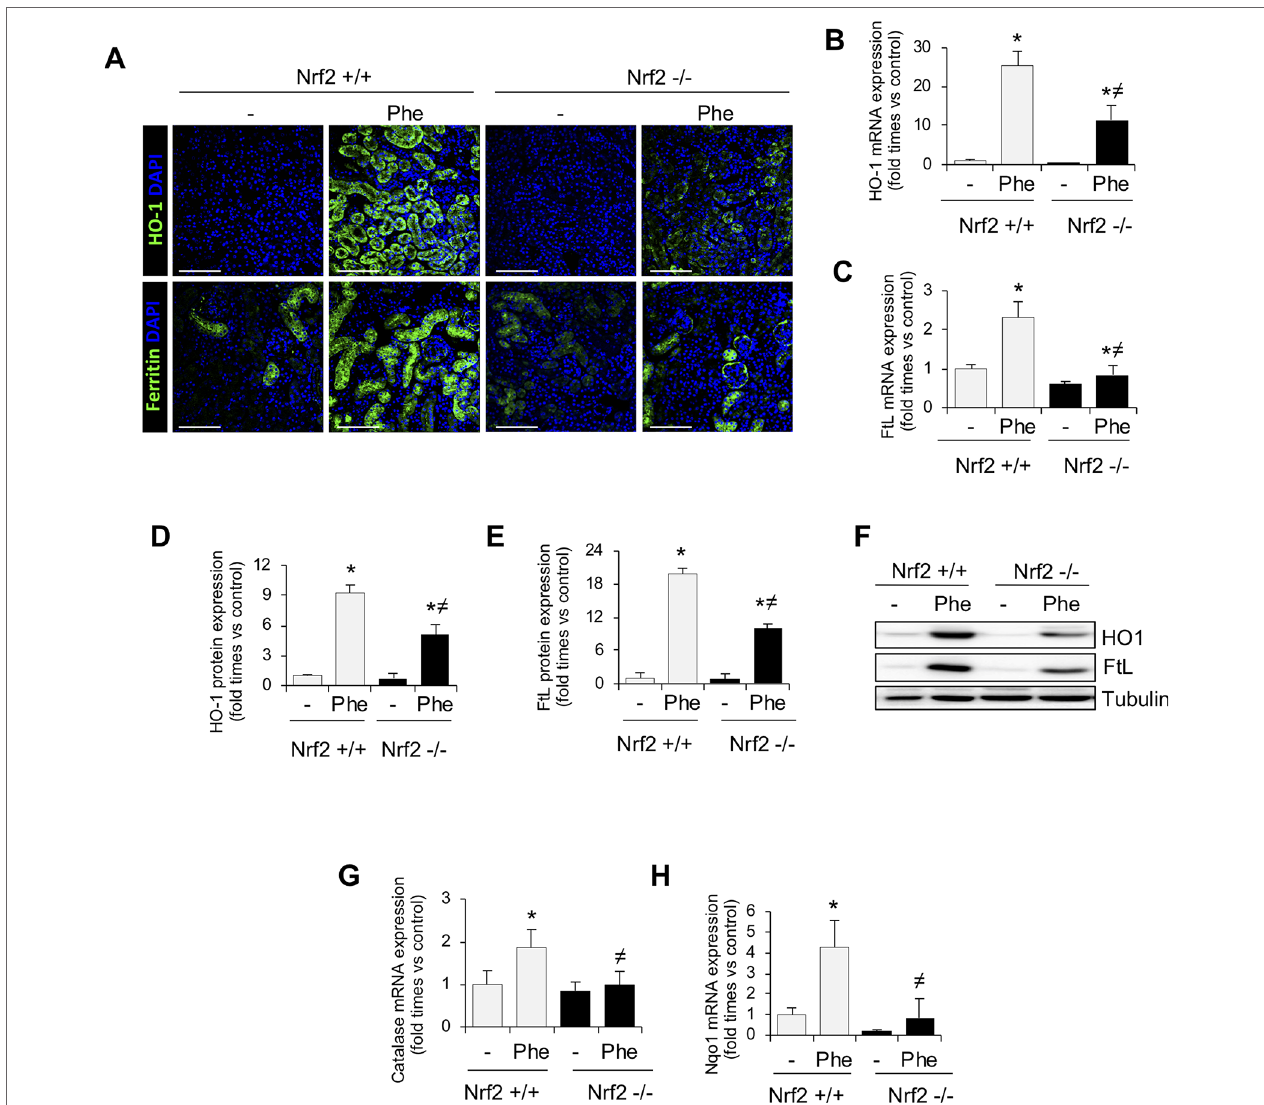
FIGURE 5 | Nrf2-related proteins in kidney from mice with intravascular hemolysis. C57BL/6 (Nrf2+/+) or Nrf2−/− mice (12 weeks old) were i.p. injected with saline (vehicle) or phenylhydrazine (Phe, 2 mg/10 g of body weight) to induce intravascular hemolysis ( n = 8/group). (A) Representative immunofluorescence images obtained by confocal microscopy showing expression of HO-1 (green, upper panel) and FtL (green, lower panel). Nuclei were stained with DAPI (blue); scale bar, 100 μm. HO-1 (B) and FtL (C) mRNA expression measured by RT-qPCR. Semi-quantification of HO-1 (D) and FtL (E) protein expression determined by western blot. (F) Representative western blot image of HO-1 amd FtL expression in kidneys from mice of the experimental model. Catalase (G) and NQO1 (H) mRNA expression measured by RT-qPCR. Results are expressed as mean ± SEM. * p < 0.05 vs Nrf2+/+ control mice, ≠ p < 0.05 vs Nrf2+/+ Phe-injected